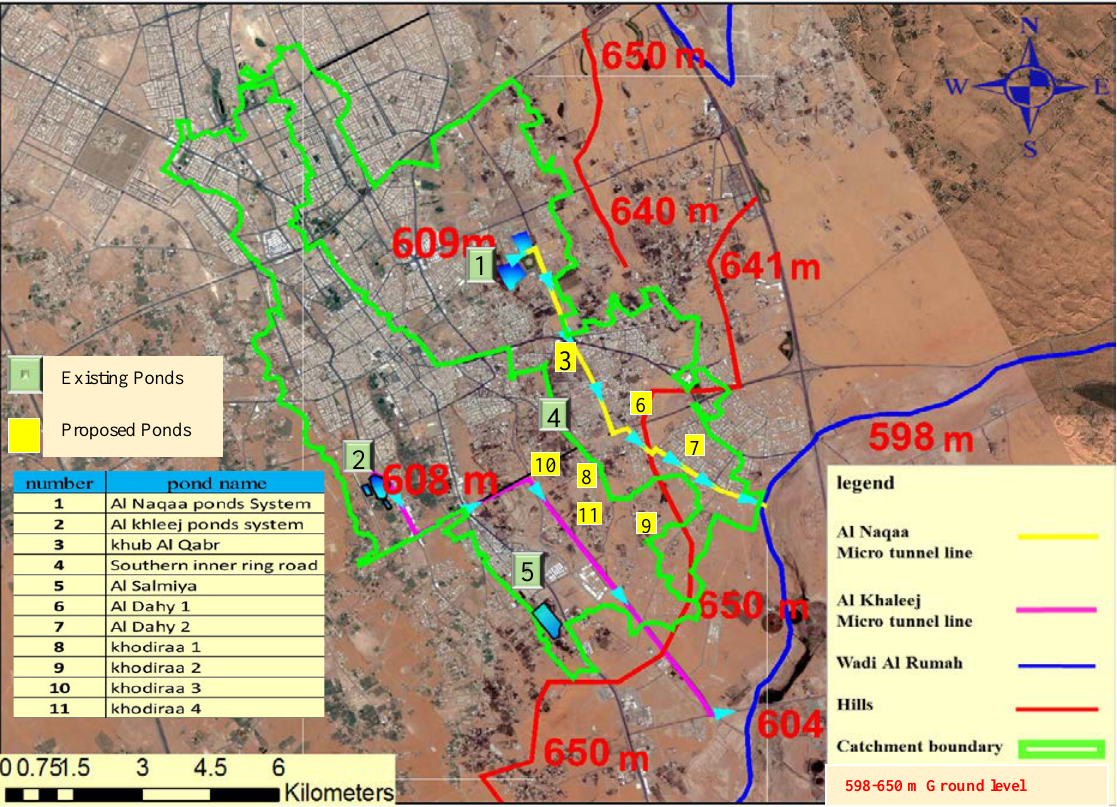
Figure 4. Location of existing and proposed ponds in the study area. Boundaries of Al Naqaa and Al Khaleej catchments are defined by green colored lines, and overall topography is defined with the help of ground levels marked red.